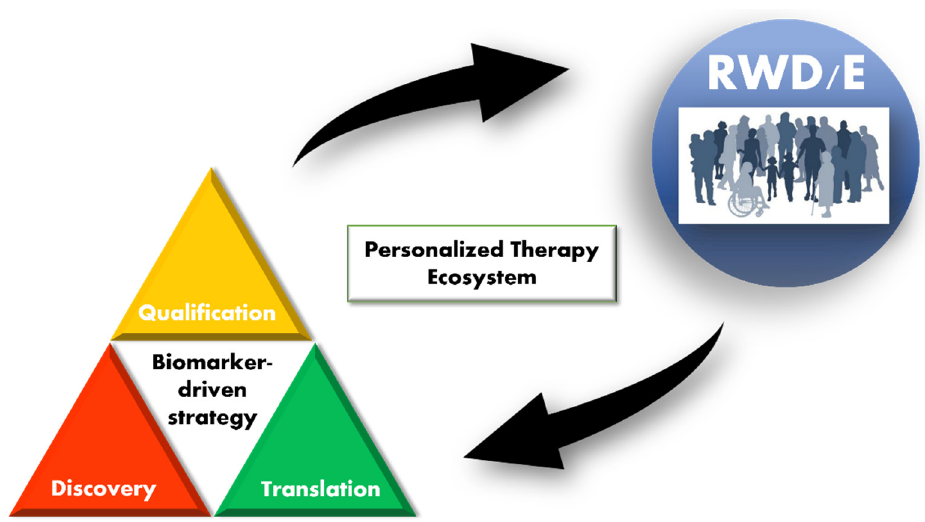
Figure 1. Personalized therapy ecosystem (PTE). A pictorial representation of a PTE. A biomarker “lifecycle” is broken down into 3 stages—discovery, translation and qualification. Biomarker testing in the clinic generates real-world data/evidence (RWD/E) that feeds back into (supports) all stages of biomarker-driven drug development. Increased efficiency in development leads to more clinically validated biomarkers that can be used in clinical practice.